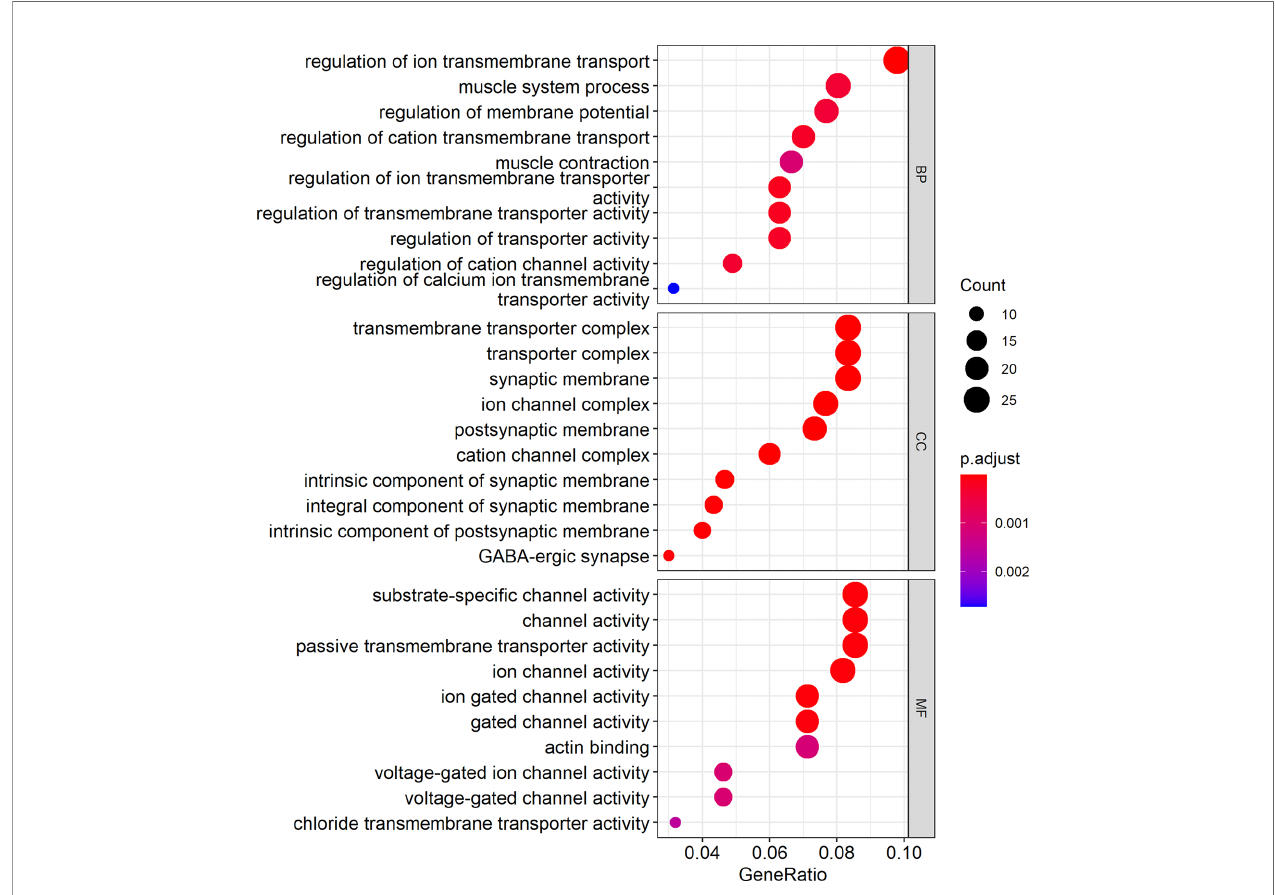
FIGURE 7 | GO analysis showed the top ten biological processes (BP), molecular functions (MF), and cell components (CC). In the fi gure, the size of the dots indicates gene count, and the color of the dots indicates the p-value. The abscissa Generatio indicates the ratio of the number of genes mapped to GO-category to the total number of genes in the